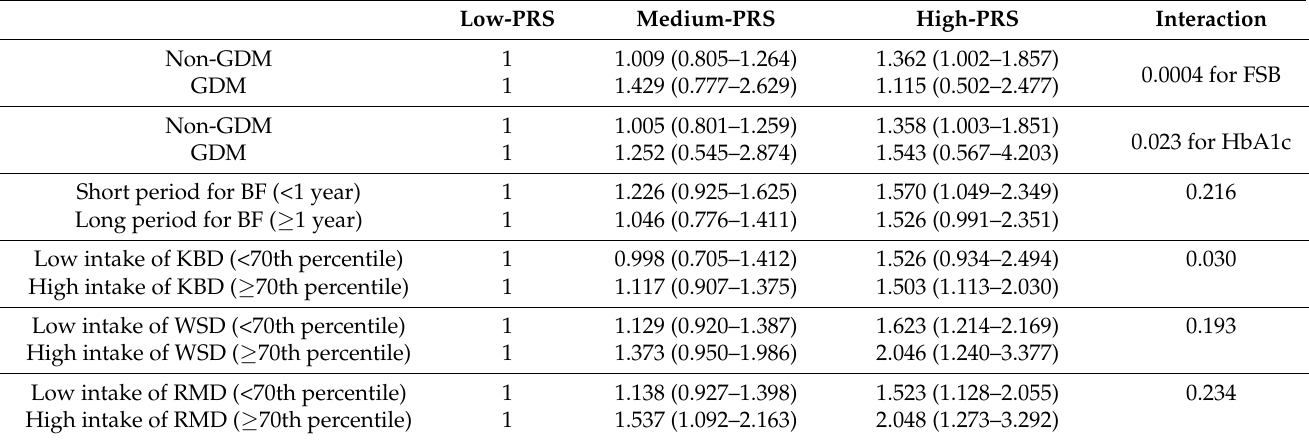
Table 5. Adjusted odds ratios of polygenetic risk scores of the 5-SNP model (PRS) for type 2 diabetes (T2DM) risk after covariate adjustments according to the patterns of lifestyles and the interaction of PRS with lifestyles for